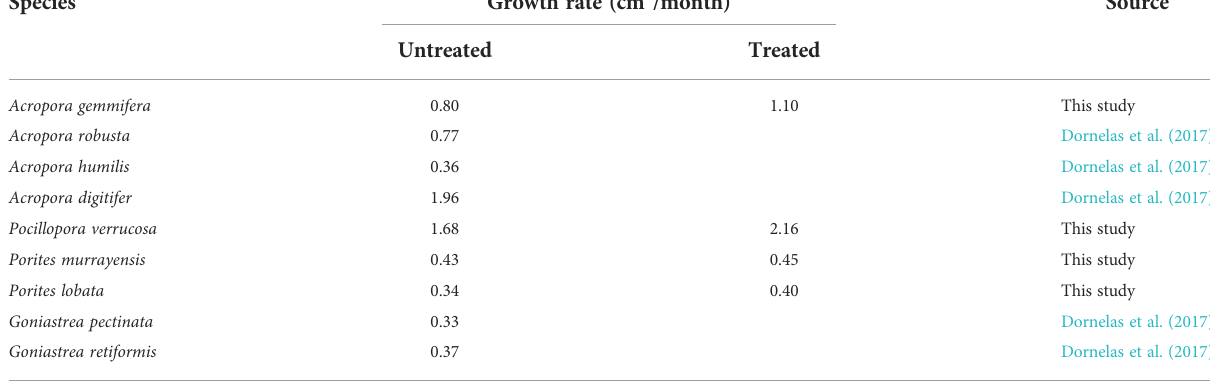
TABLE 3 Growth rate of hard coral derived from literatures and present study.